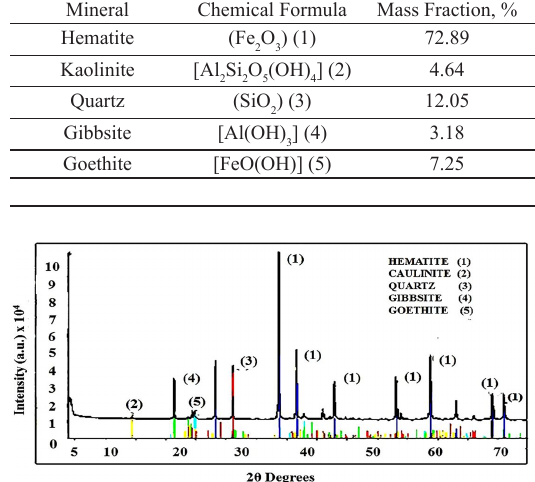
Table 1. Composition of the medium used for growth of the burkolderia caribensis bacteria strain. Compound Chemical Formula